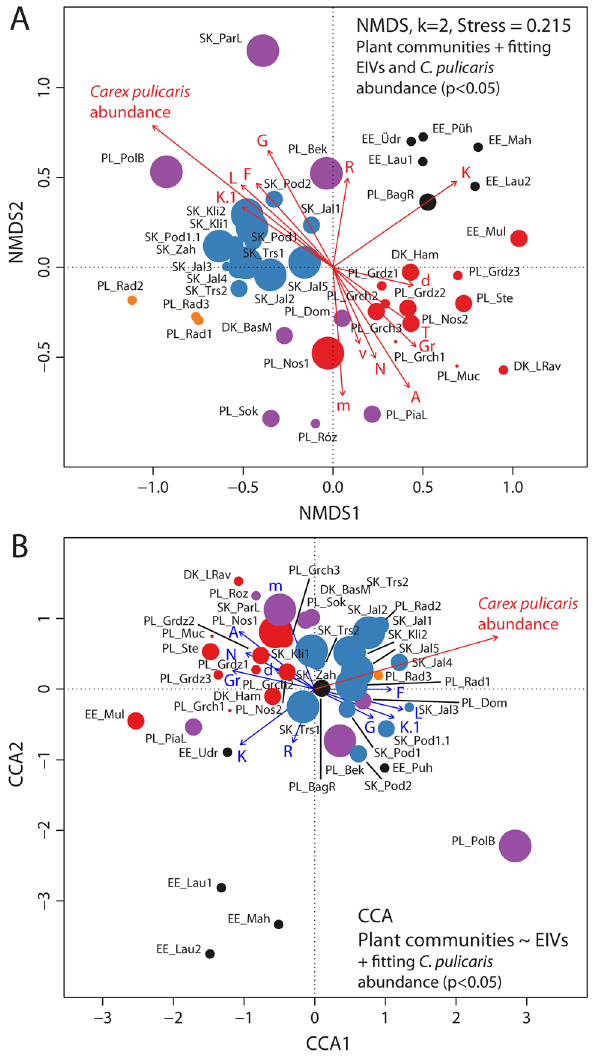
Figure 4. Ordination biplot of non-metric multidimensional scaling (NMDS) and canonical correspondence analysis (CCA). ( A ) NMDS of species composition data showing grouping of localities with maximal variance explained along NMDS1 and NMDS2. Ellenberg indicator values (EIVs, p < 0.05) fitted to ordination biplot; ( B ) Canonical correspondence analysis (CCA) performed on matrices of species composition data and mean EIVs. Only significant variables (p < 0.05) explaining constrained variation, identified based on forward selection, were used in parsimonic CCA. Locality abbreviations follow Table 1. Colouring corresponds to clustering pattern, symbol size reflects Carex pulicaris abundance. Carex pulicaris abundance vector is fitted to NMDS and CCA models (p < 0.05). Colouring of symbols: black—Estonian group, blue—Slovakian group, orange—Radecz group, purple—Ambiguous group, red—Polish